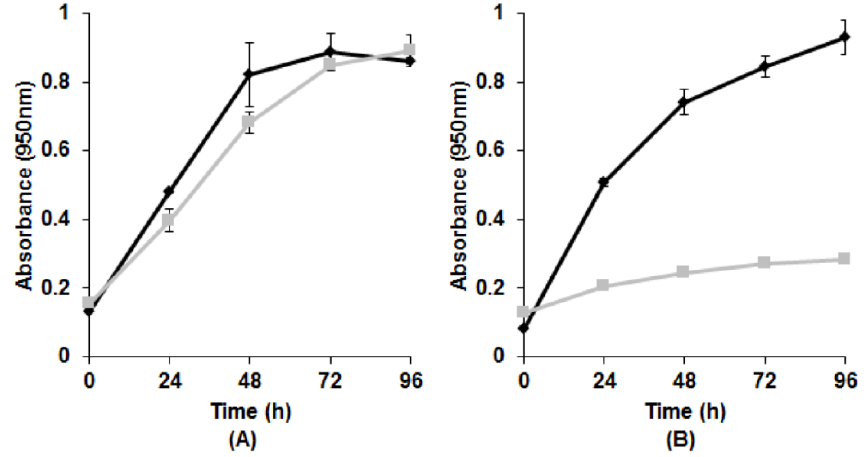
Figure 2. Growth and reduction during primary vs. secondary exposure to K 2 TeO 3 . ( A ) Strain KR99. Similar results for E1, E5, RB3, and RB 16-17; ( B ) Strain E4(1). ♦—Primary exposure; ▀—Secondary exposure. Error bars represent one standard